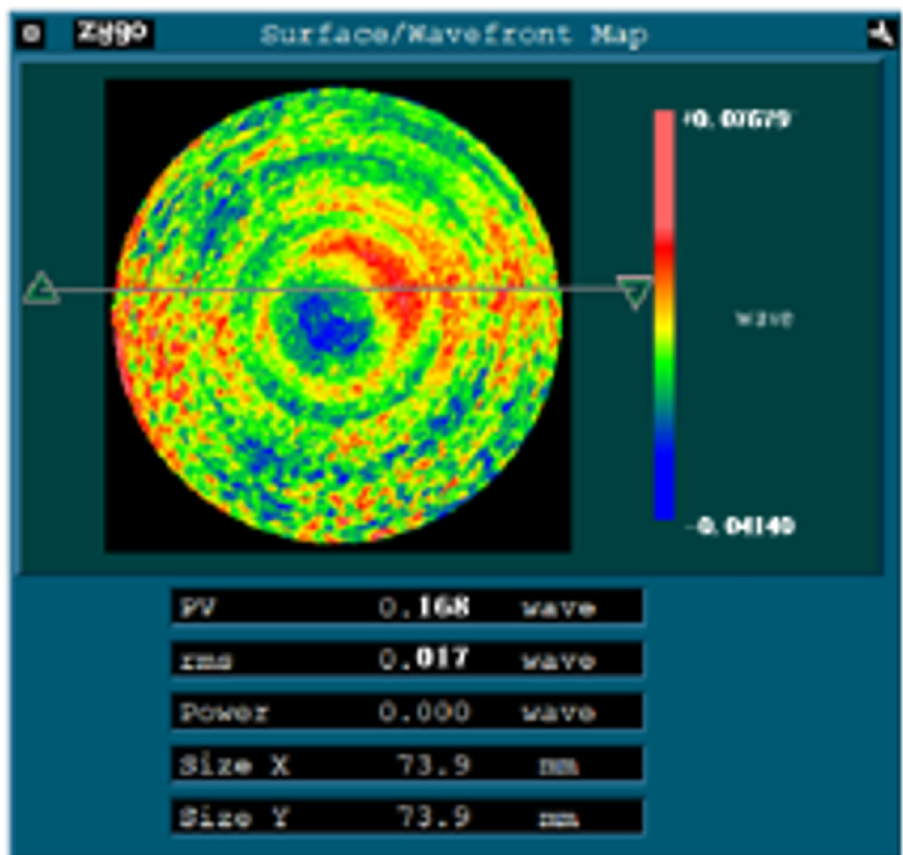
Fig 14. The result of third compensation